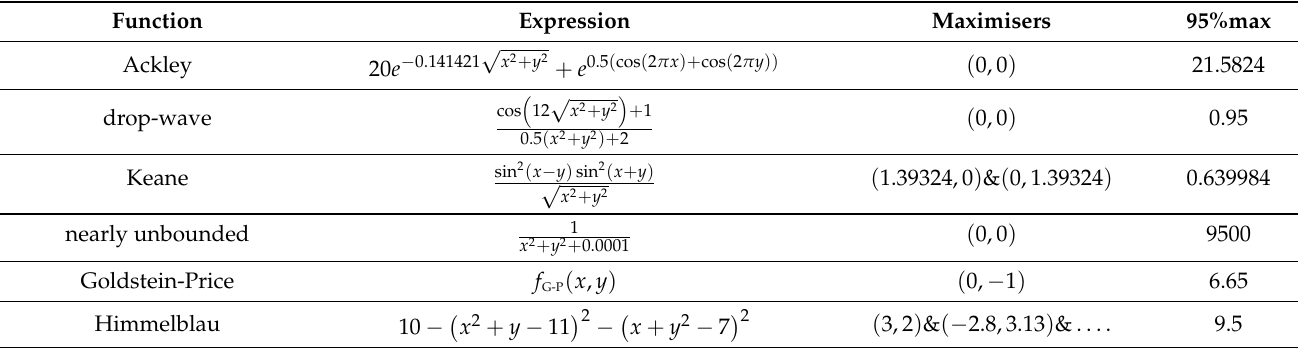
Table A1. Some characteristics of the slightly modified test functions